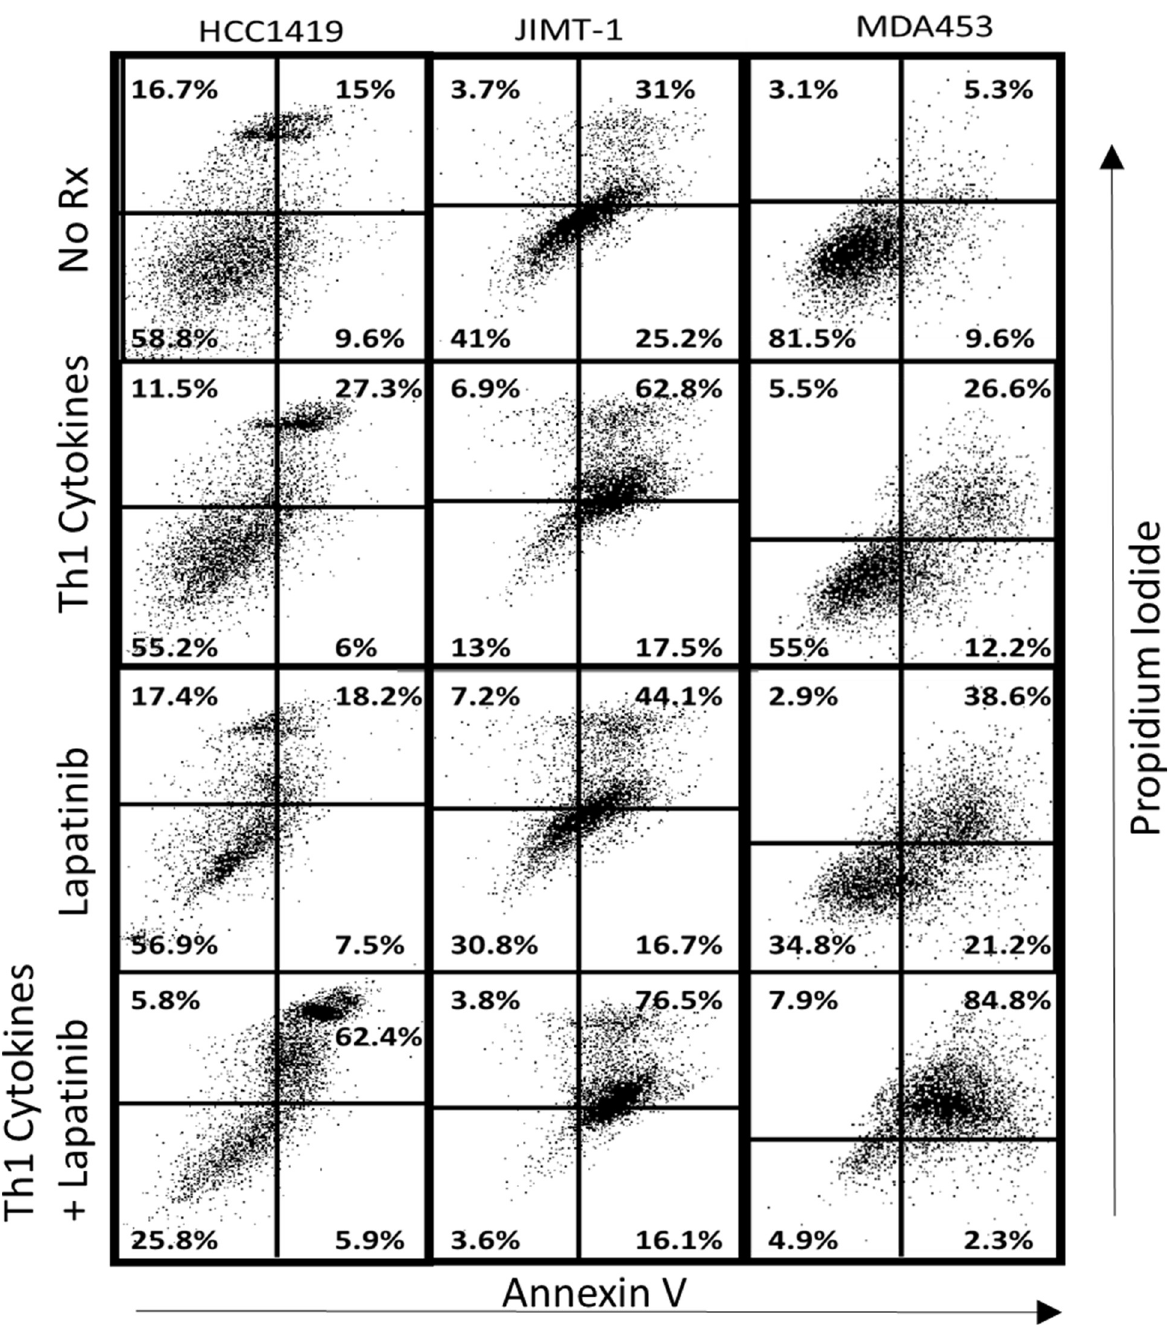
Fig 7. Lapatinib works in conjunction with Th1 cytokines to maximize indicators of apoptotic cell death in drug-resistant cell lines. Cultured HCC1419, JIMT-1 and MDA-MB-453 cells were treated either with Th1 cytokines (TNF- α plus IFN- γ ; 20 and 12.5ng/ml respectively), Lapatinib (2 μ M), Lapatinib plus Th1 cytokines or left untreated (control). After 72 hours incubationcells were harvested and stained with FITC-Annexin V and propidium iodide (PI) and subjected to FACS analysis. Two-color dot-plot analysis displays percentage of gated cells in each quadrant (double- staining cells represent late apoptotic